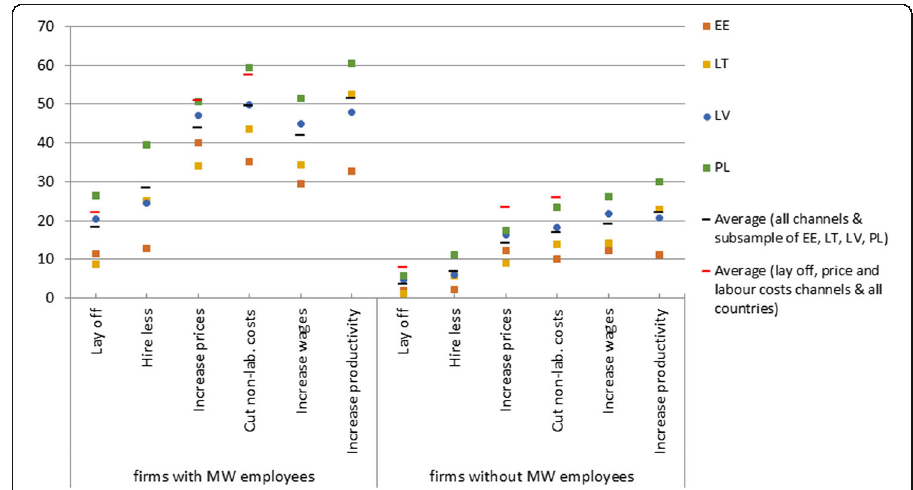
Fig. 3 Predicted probabilities for the relevance of adjustment channels by country (all channels, a subset of countries). Source: Authors ’ calculations using the multivariate probit model presented in Tables 5 and